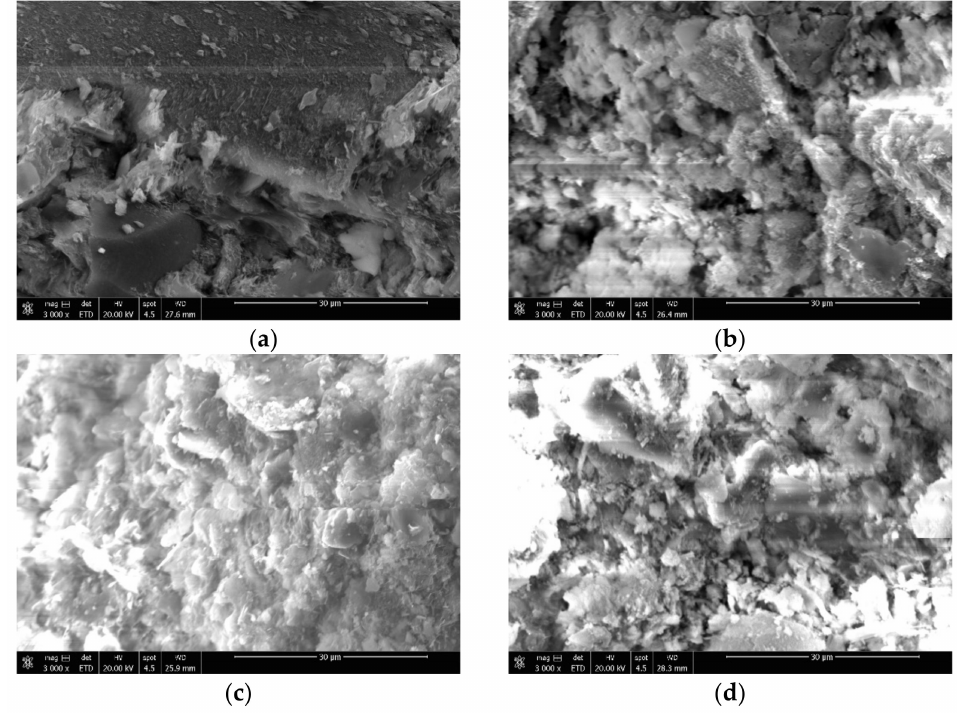
Figure 6. SEM of Ni-Fe Slag Powder Sandy Soil Cement ( × 3000). ( a ) 7 d topography of A s ; ( b ) 7 d topography of E s ; ( c ) 60 d topography of A s ; ( d ) 60 d topography of E s